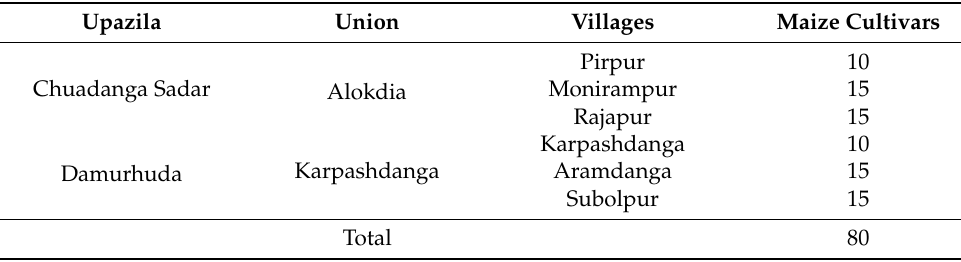
Table 1. Distribution of sample farmers in the study